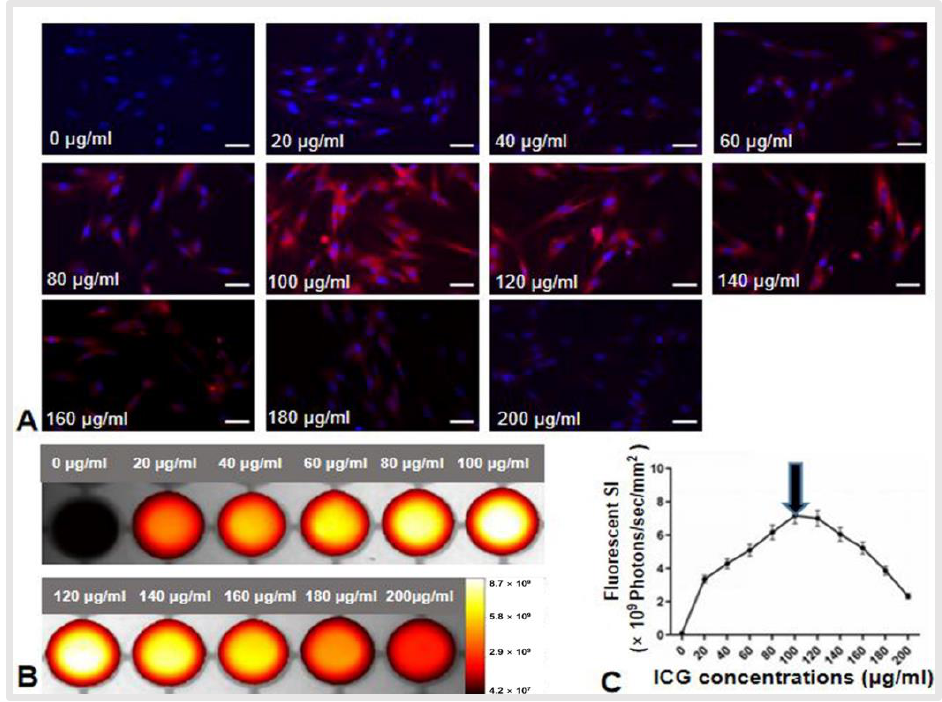
Figure 1. Optimization of indocyanine green (ICG) dose for optical imaging of ICG-treated VX2 cells (ICG cells). ( A ) Fluorescent microscopy images showed an increased intensity of the ICG fluorescence signals as ICG concentrations increased from 0 to 100 μg/mL and then decreased intensity as ICG concentrations increased from 100 to 200 μg/mL. Scale bars, 50 μm. ( B ) Optical/X-ray images of ICG cells showed similar results in terms of an increased fluorescent signal intensity (SI) as ICG concentrations increased from 0 to 100 μg/mL and a decreased SI as ICG concentrations increased from 100 to 200 μg/mL, ( C ) which was further confirmed via quantitative analysis of fluorescent SI.